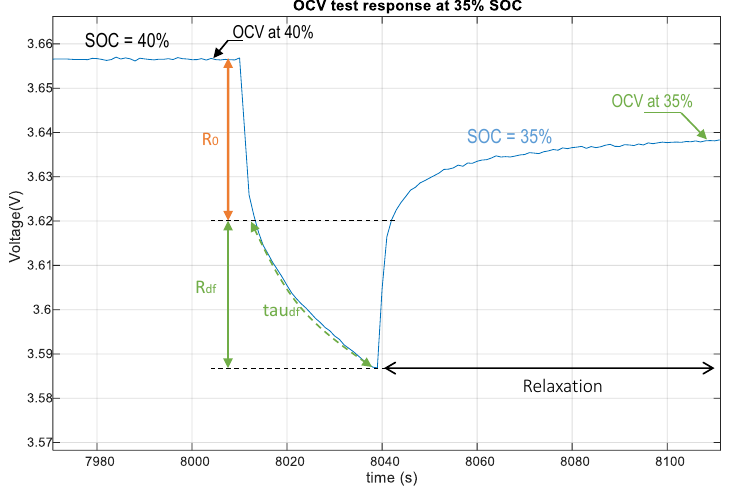
Figure 3. Parameters extraction form OCV test at SOC =